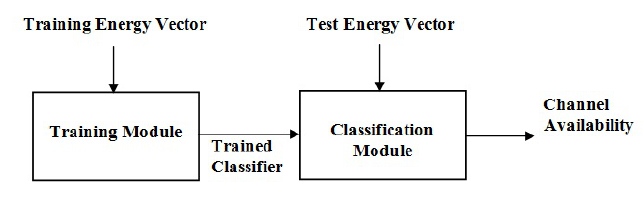
Figure 3. Schematic representation of learning module for proposed CSS